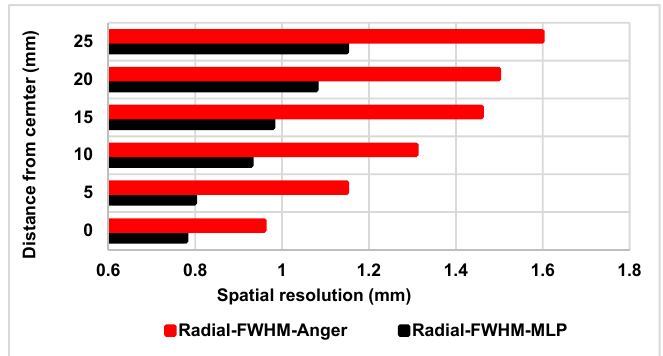
Figure 2. Spatial resolution of one detector module for a point source at six distances from the center of the crystal along the radial direction.